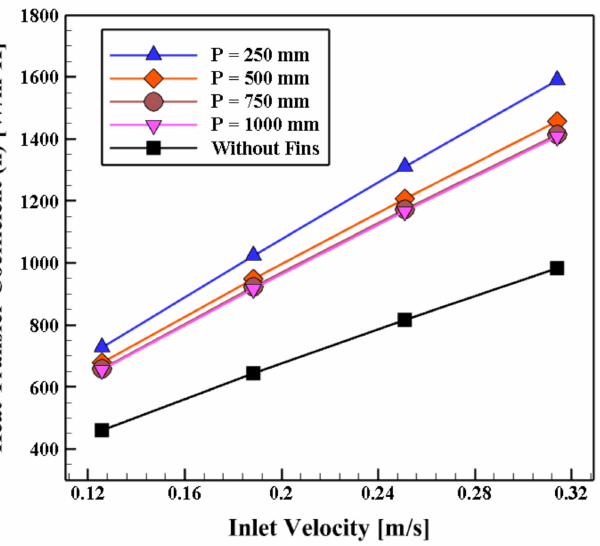
Figure 13. Heat transfer coefficient variation with the inlet velocity for various pitches of inner helical axial